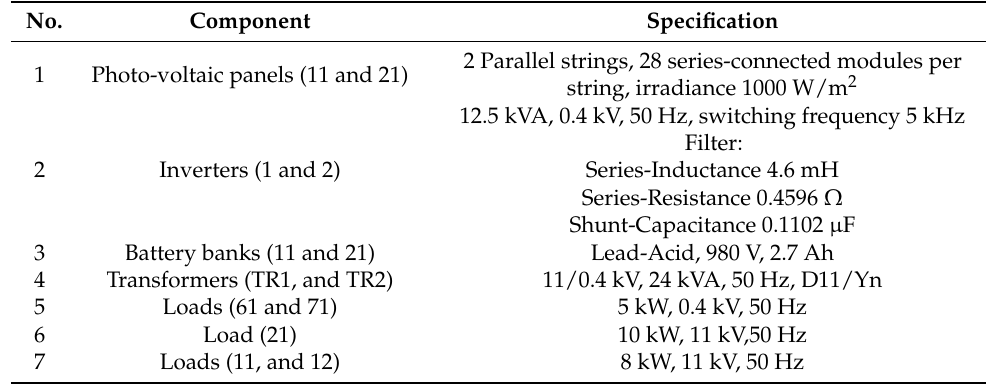
Table 2 tabulates the distributed grid component specifications. Table 2. The distributed grid component